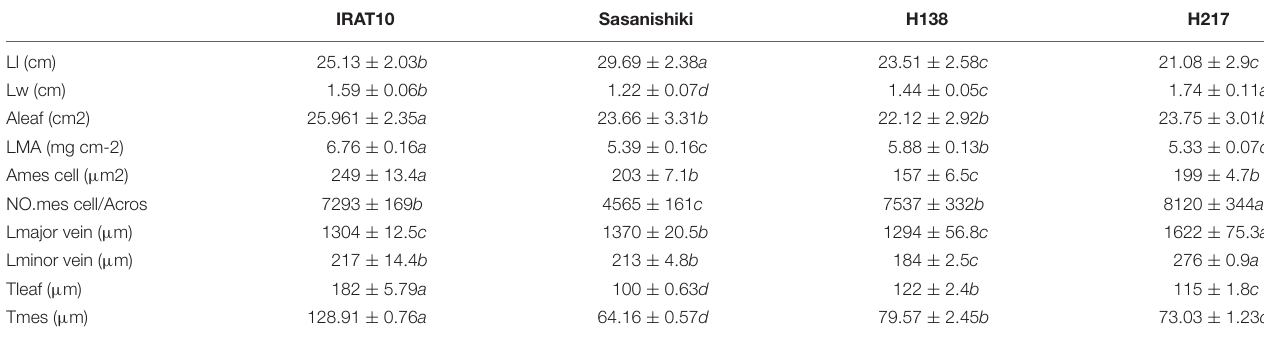
TABLE 1 | Leaf length (L l , cm), leaf width (L w , cm), leaf area (A leaf , cm 2 ), leaf mass per unit area (LMA, mg cm − 2 ), the distance between two major veins (L majorvein , µ m), the distance between two minor veins (L minorvein , µ m), the cross-area of a single mesophyll cell (A mescell , µ m 2 ), the mesophyll cell number per cross-sectional